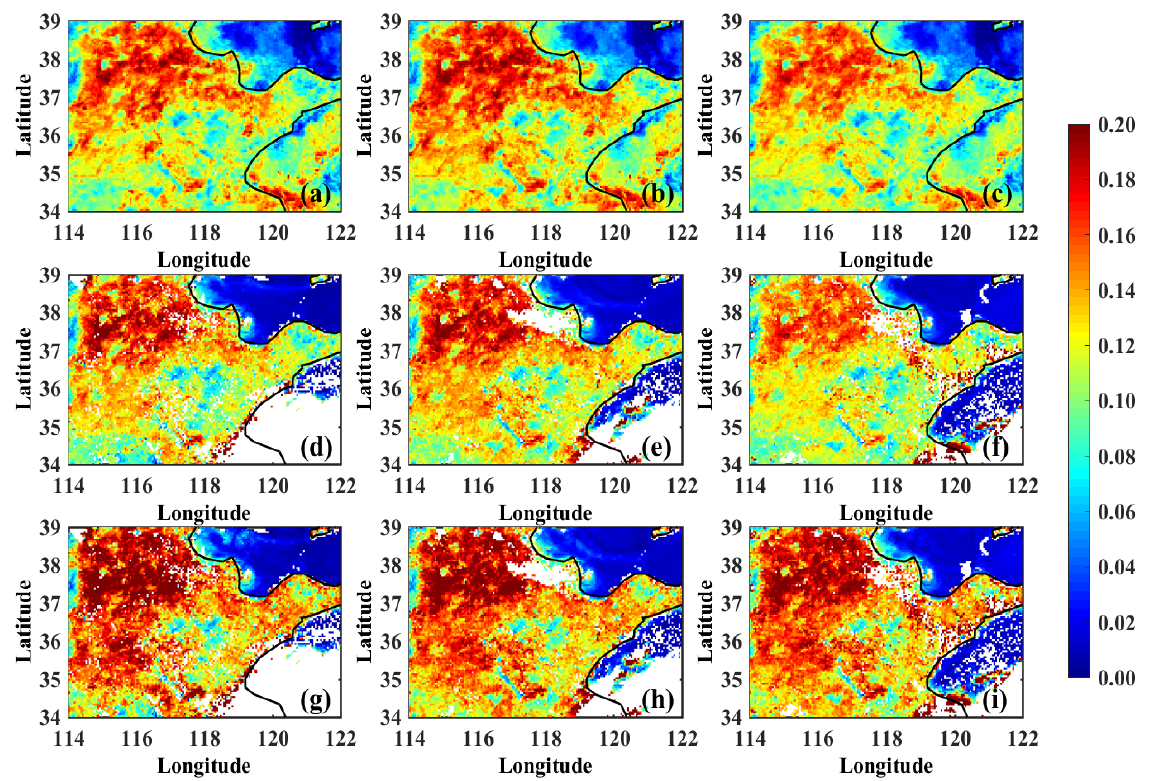
Figure 6. ( a – c ) are the AHI red-band reflectance at 00:00 UTC, 02:00 UTC and 04:00 UTC on 1 July 2019 computed from mcd43 coefficient respectively. ( d – f ) correspond to the reflectance after atmospheric correction. ( g – i ) are the reflectance after both atmospheric and angle corrections.